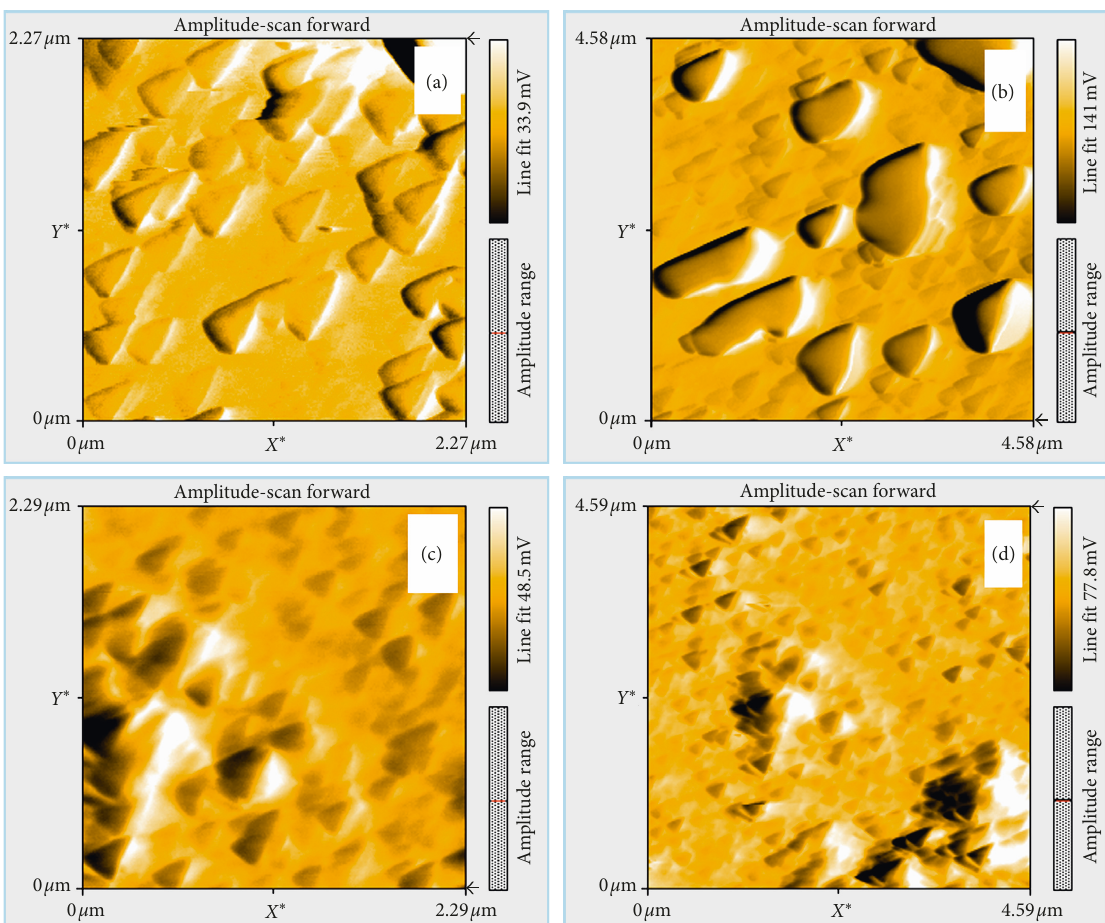
Figure 11: AFM images for MnTTPCl before (a, b) and after exposure to β -carotene (c, d).